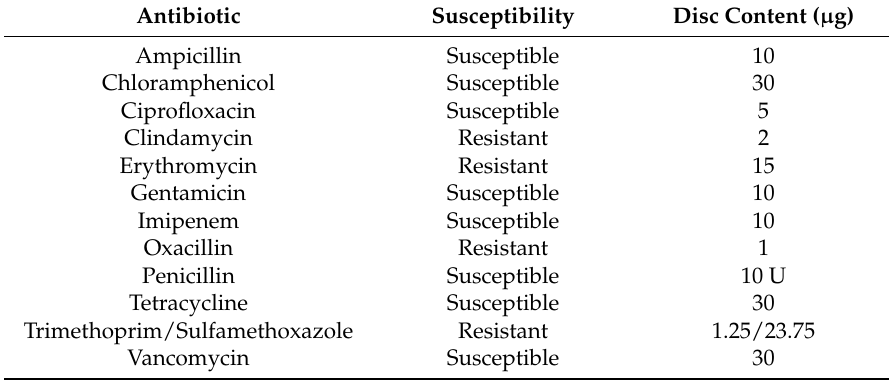
Table 1. Drug susceptibility testing of the human Listeria monocytogenes isolate. Clinical and